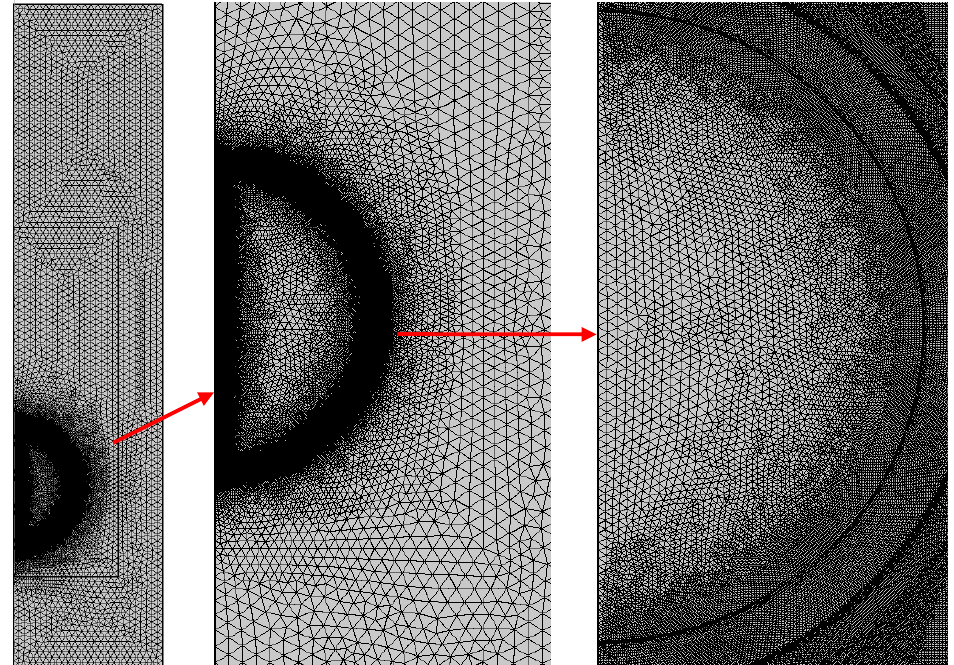
Figure 3. The mesh structure for a droplet radius of 0.0025 m. Table 2. Mesh statistics.